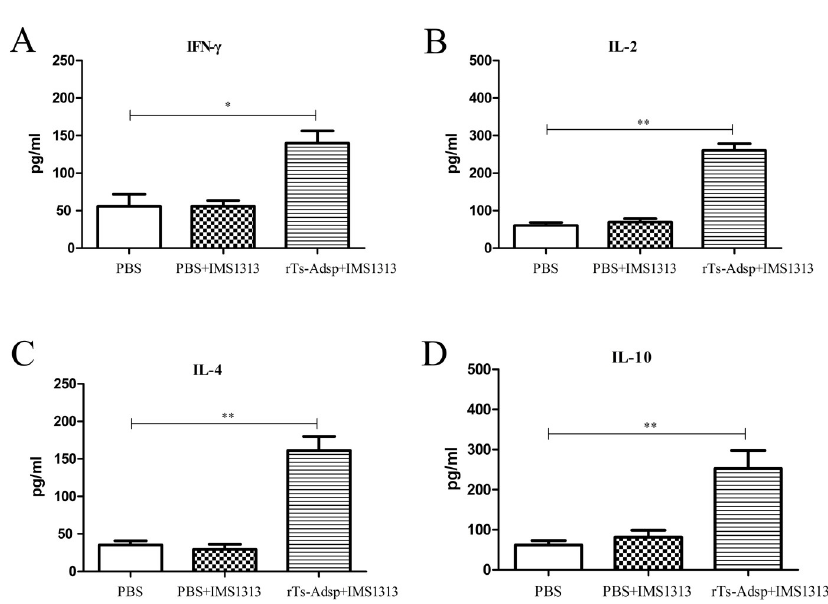
Fig 3. Cytokine production from sera were evaluated by ELISA. The levels of (A) IFN- γ (B) IL-2 (C) IL-4 (D) IL-10 are presented as the mean ± SD (n = 6). Asterisks indicate that the production of cytokines from immunized group are significantly different from ( � p < 0.05, �� p < 0.01, ��� p < 0.001) that of PBS control group.